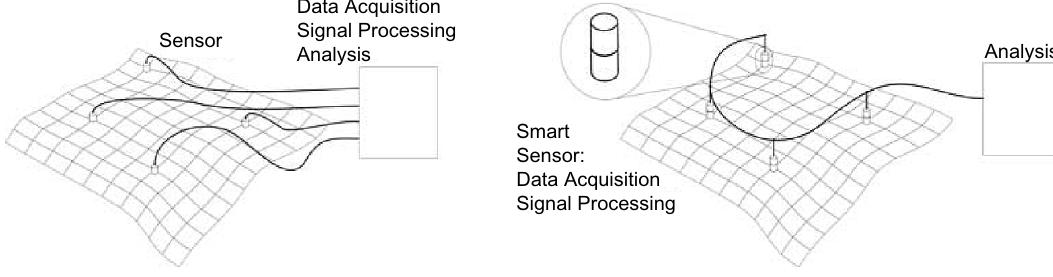
Fig. 1. SHM system with centralized acquisition and processing unit versus system with smart